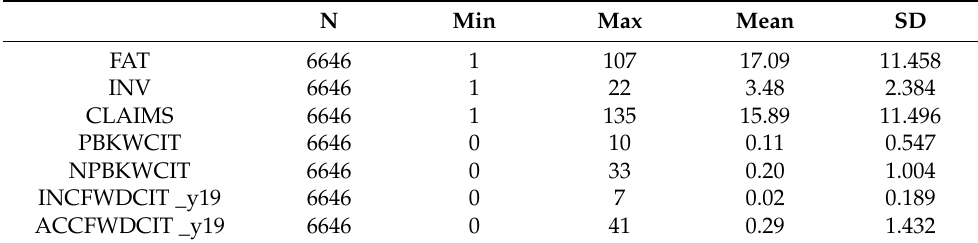
Table 1. Descriptive statistics of patent